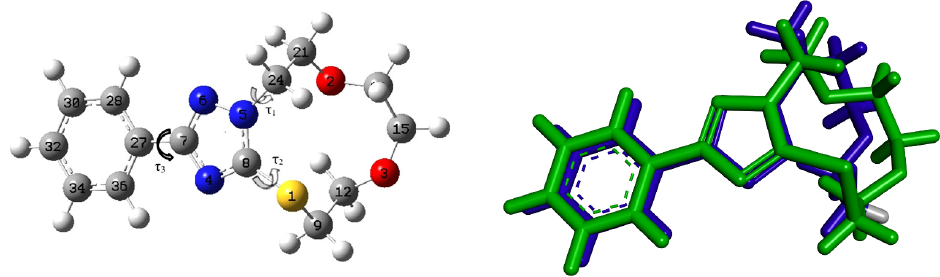
Figure 4. Packing of 3 viewed along the c-axis direction with C–H ⋅⋅⋅ S hydrogen bonds and C– H ⋅⋅⋅ π (ring) and O ⋅⋅⋅ S interactions depicted, respectively, by brown, green, and yellow dashed lines. Non-interacting hydrogen atoms are omitted for clarity.